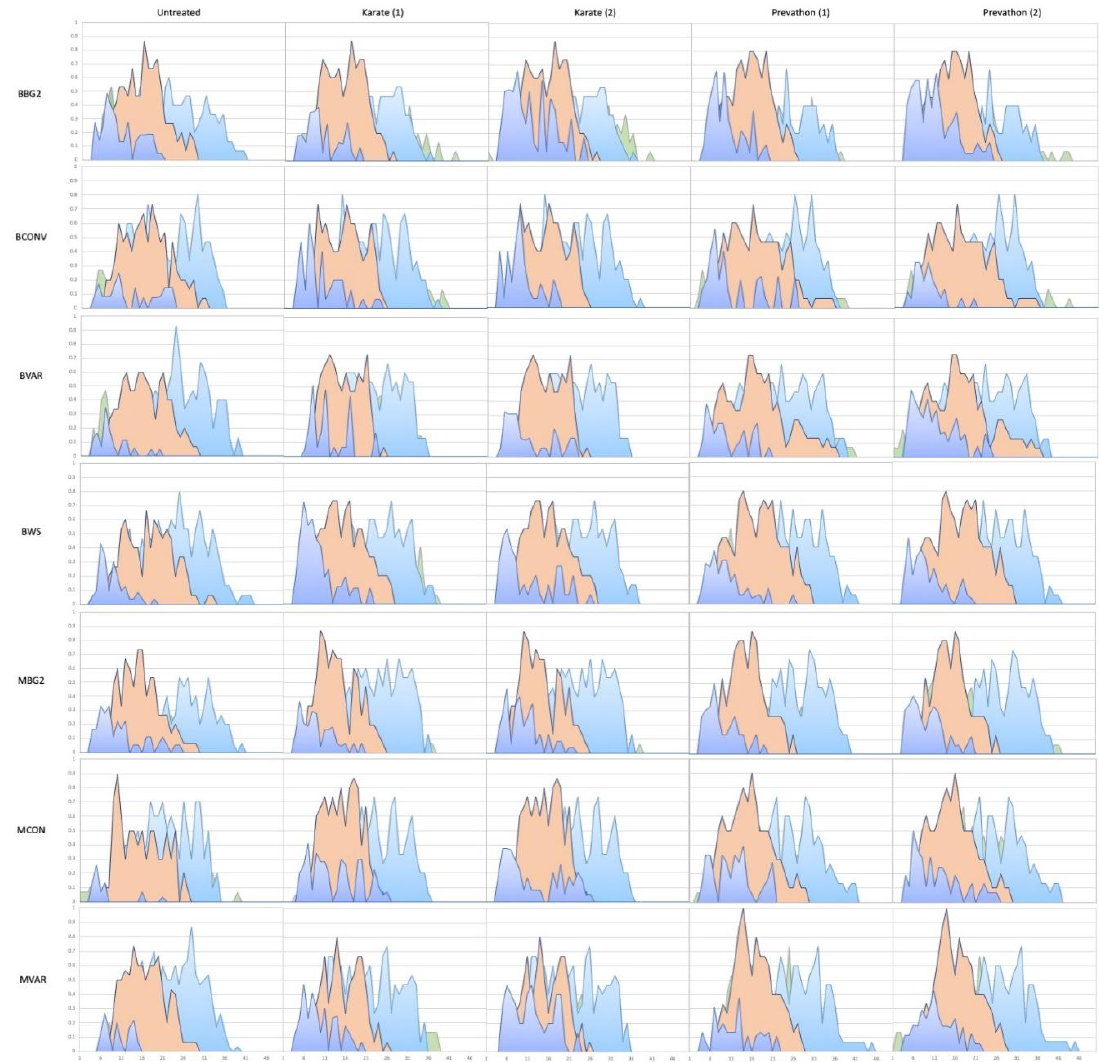
Figure 2. Retention of 1st position fruit (probability of fruit at different mainstem nodes) during 2012. Plant map dates are indicated on 17 July 2012 (green), 3 August 2012 (blue), 15 August 2012 (orange) and at harvest (20 October 2012; purple). Dates are presented from earliest (furthest back on the graph) to harvest (foremost). The left column of graphs shows the pattern of fruit retention on untreated plants, while the other columns show comparative patterns for the same variety treated once or twice with Karate or Prevathon. The x -axis indicates the mainstem node number (from bottom to top of plant), while the y -axis indicates probability of fruit at each node.